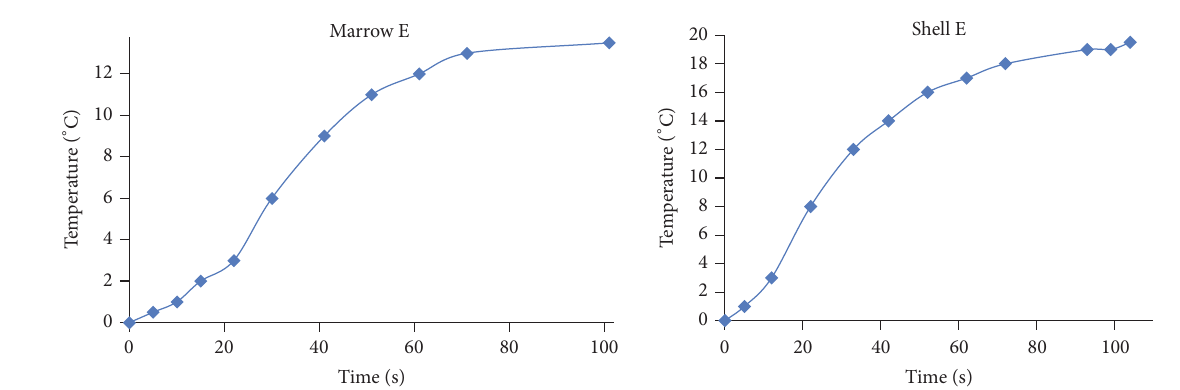
Figure 8: Experimental thermogram of a point in the plane located 2 mm from the surface irradiated (B).